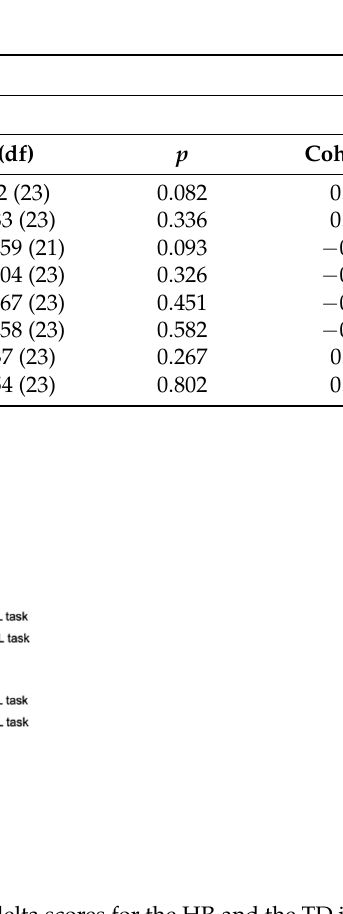
TD and HR subsamples of infants who participated in both tasks. The two groups are homogeneous